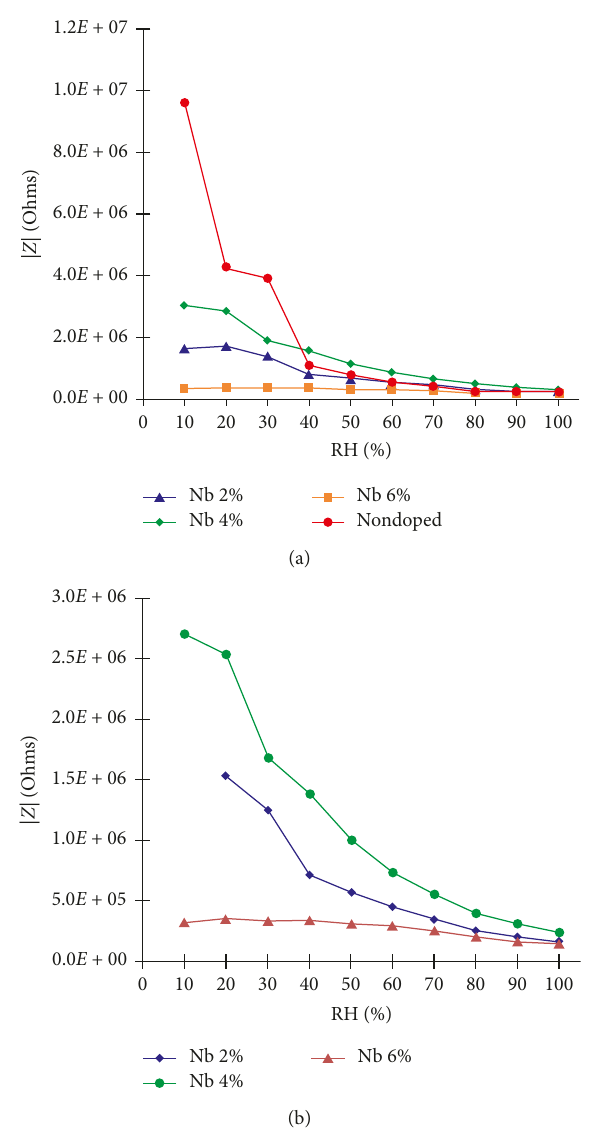
Figure 6: Impedance change with RH, at 1.3 kHz (a) and 4 kHz (b), at 20 ° C for all three sensors (it was not possible to calculate values of the impedance modulus for 10% RH in the TiW-Nb2 sensor at 4